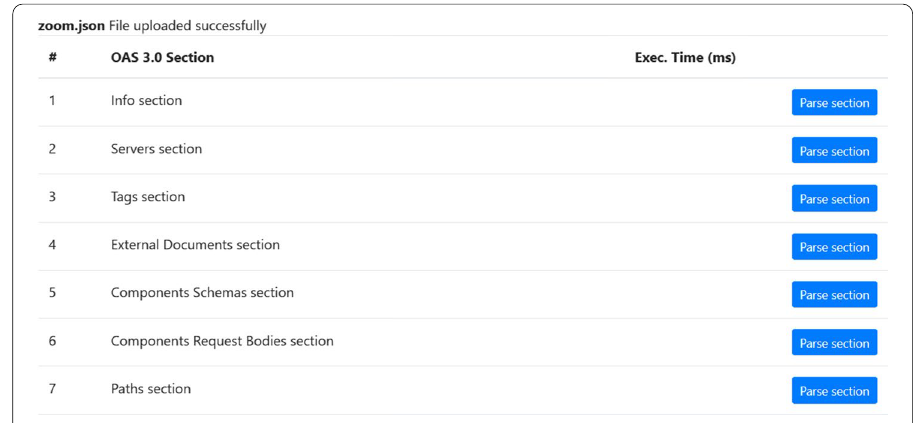
Fig. 10 OAS document extraction